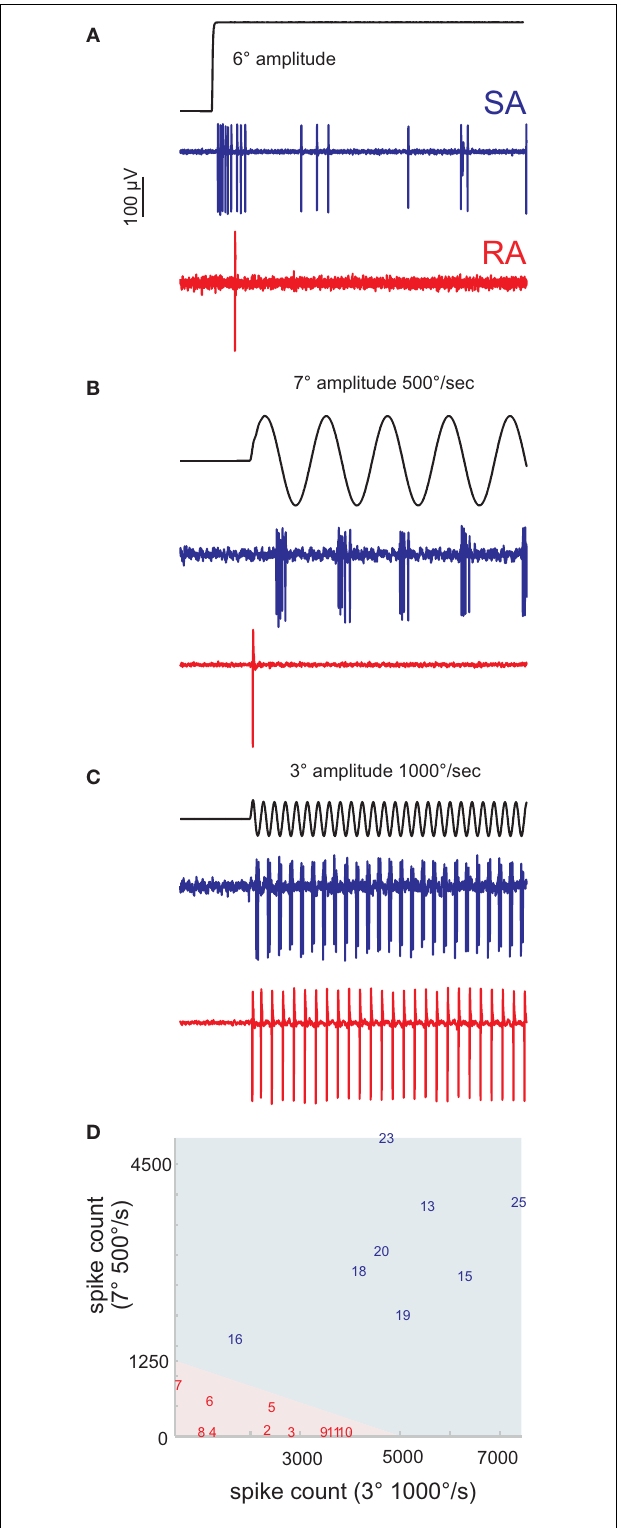
FIGURE 1 | Classification of primary afferents. (A) Typical responses of rapidly (RA) and slowly adapting (SA) primary afferents to a ramp-and-hold stimulus in the preferred direction of the cell. (B,C) Discriminative